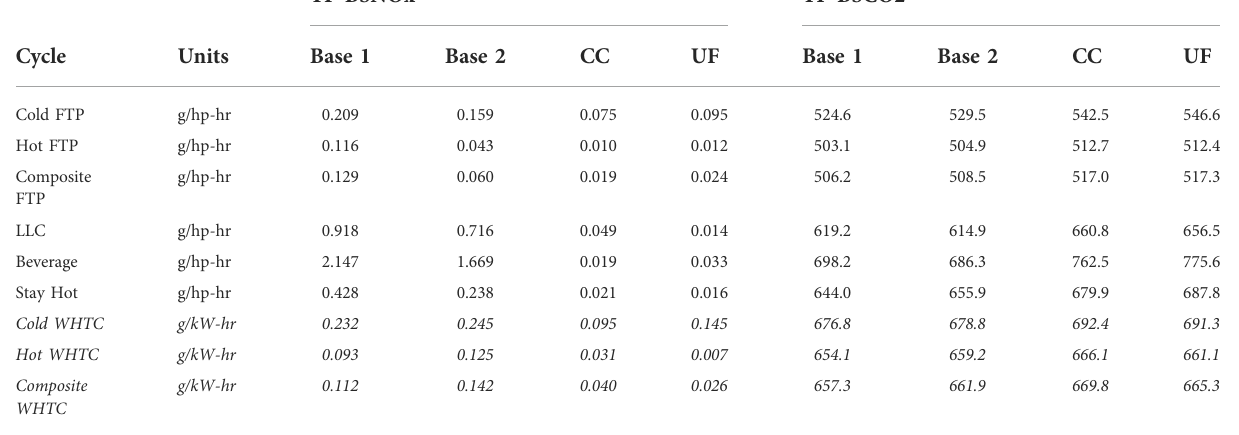
TABLE 12 Summary TP BSNO x and TP BSCO 2 test